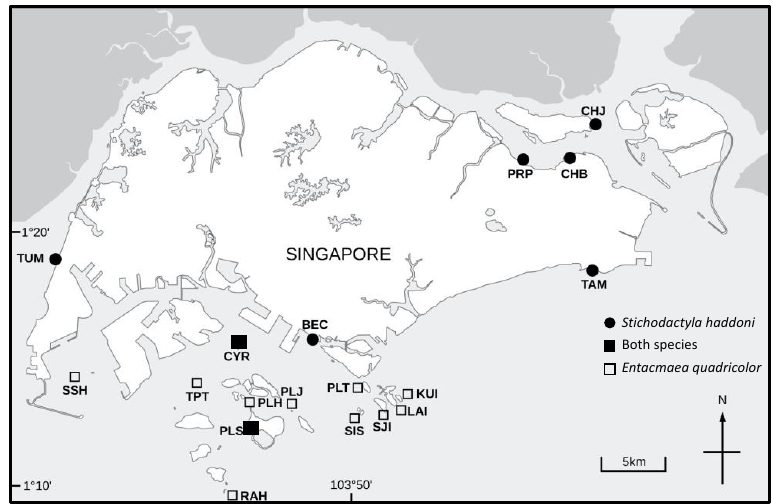
Figure 2. Sampling locations of Stichodactyla haddoni and Entacmaea quadricolor . BEC—Berlayer Creek,